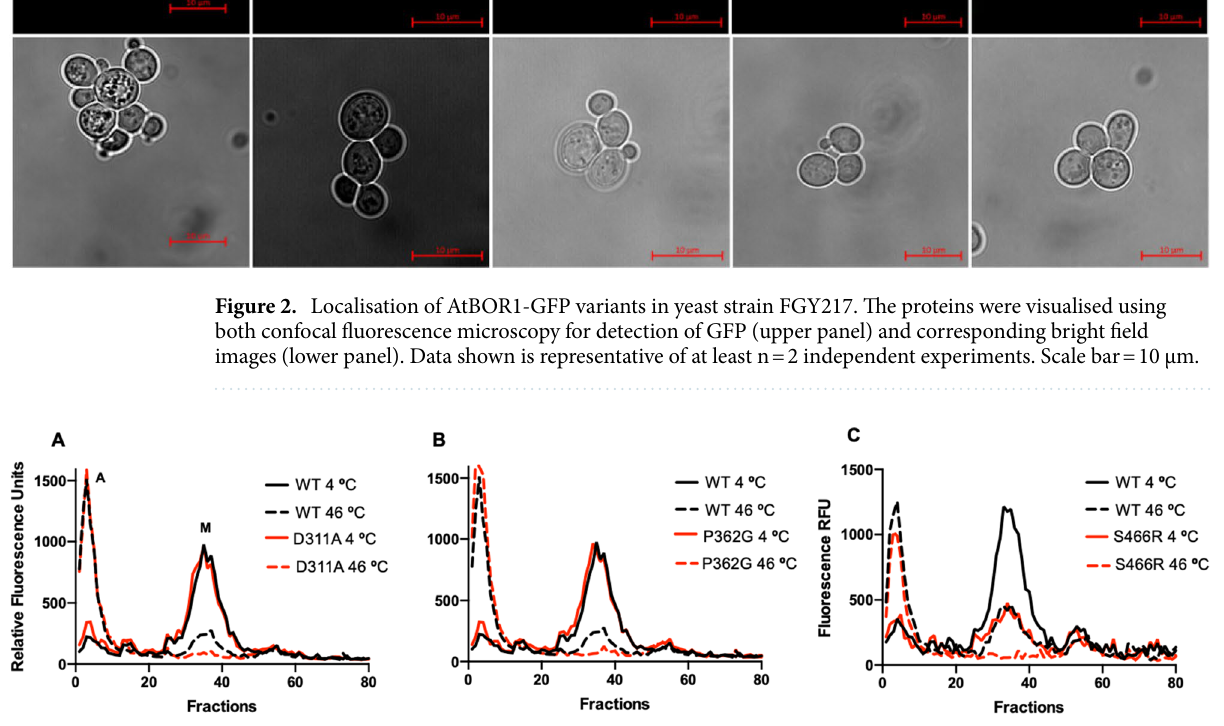
Figure 3. FSEC and hFSEC analysis of AtBOR1 proteins. FSEC analysis is carried out on protein solubilised at 4 °C prior to separation on the SEC column and hFSEC analysis is carried out on protein initially prepared in the same way then heated at 46 °C for 10 min, prior to separation on the SEC column. In each case, aggregated material elutes at roughly fraction 8, with monodispersed protein eluting at roughly fraction 35, labelled A and M respectively on ( A ). ( A – C ) Show the results obtained for D311A, P362G and S466R variants compared to WT AtBOR1 analysed at the same time, respectively. In each case the elution trace obtained for unheated sample is shown in the solid line while the elution trace obtained for heated sample is shown in the same coloured dashed line. Data is representative of at least n = 2 independent